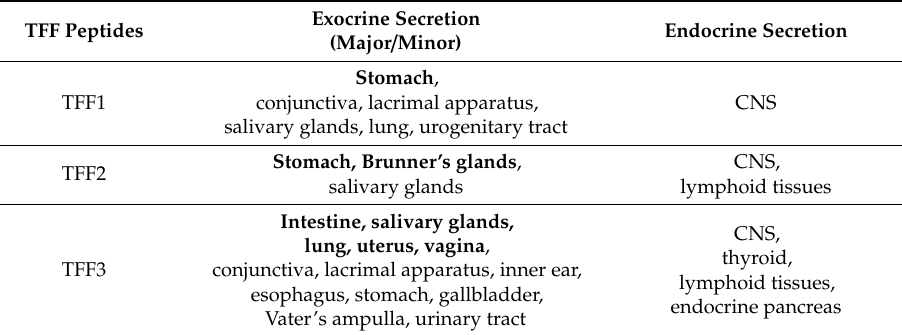
Table 1. Expression sites of human TFF